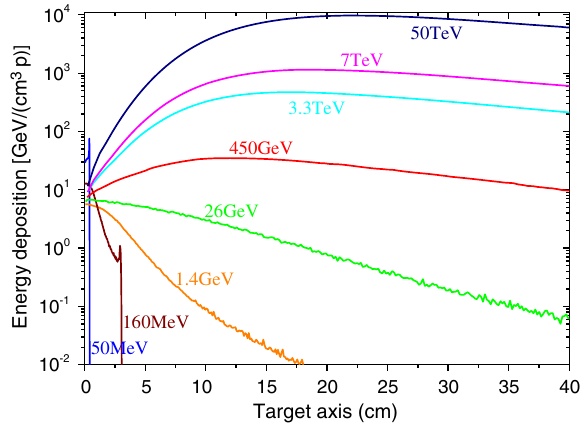
FIG. 5. Energy deposition per incident proton as a function of the depth into the solid copper target at r ¼ 0 . The beam size is constant (0.2 mm) for the energies from 50 MeV to 50 TeV. It is previous work.